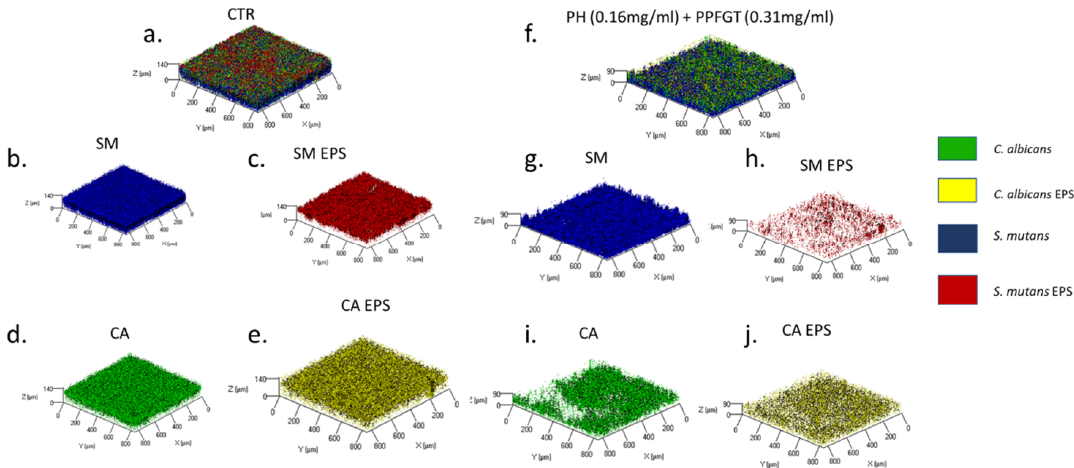
Figure 2. Biofilm 3D reconstruction of confocal laser scanning microscopy. Computerized 3D reconstruction (X, Y, and Z axis) of the biofilm layers (in µm), recorded using CLSM and generated by the zen2009 software. ( a ) Control S. mutans and C. albicans cells and EPS. ( b ) S. mutans cells only. ( c ) S. mutans EPS only. ( d ) Candida cells only. ( e ) Candida EPS only. ( f ) Treated S. mutans and C. albicans biofilm. ( g ) S. mutans cells only. ( h ) S. mutans EPS only. ( i ) Candida cells only. ( j ) Candida EPS only.